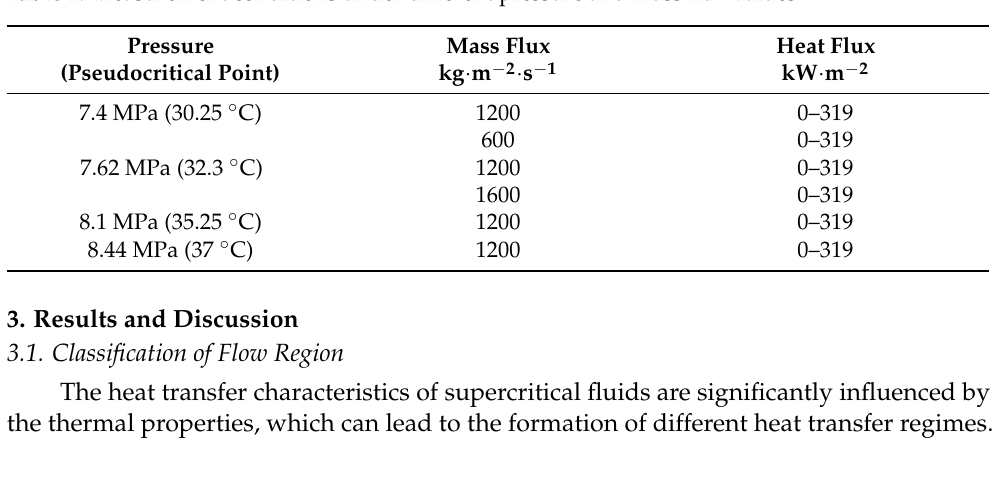
Figure 2. Test section and distribution of measurement points.